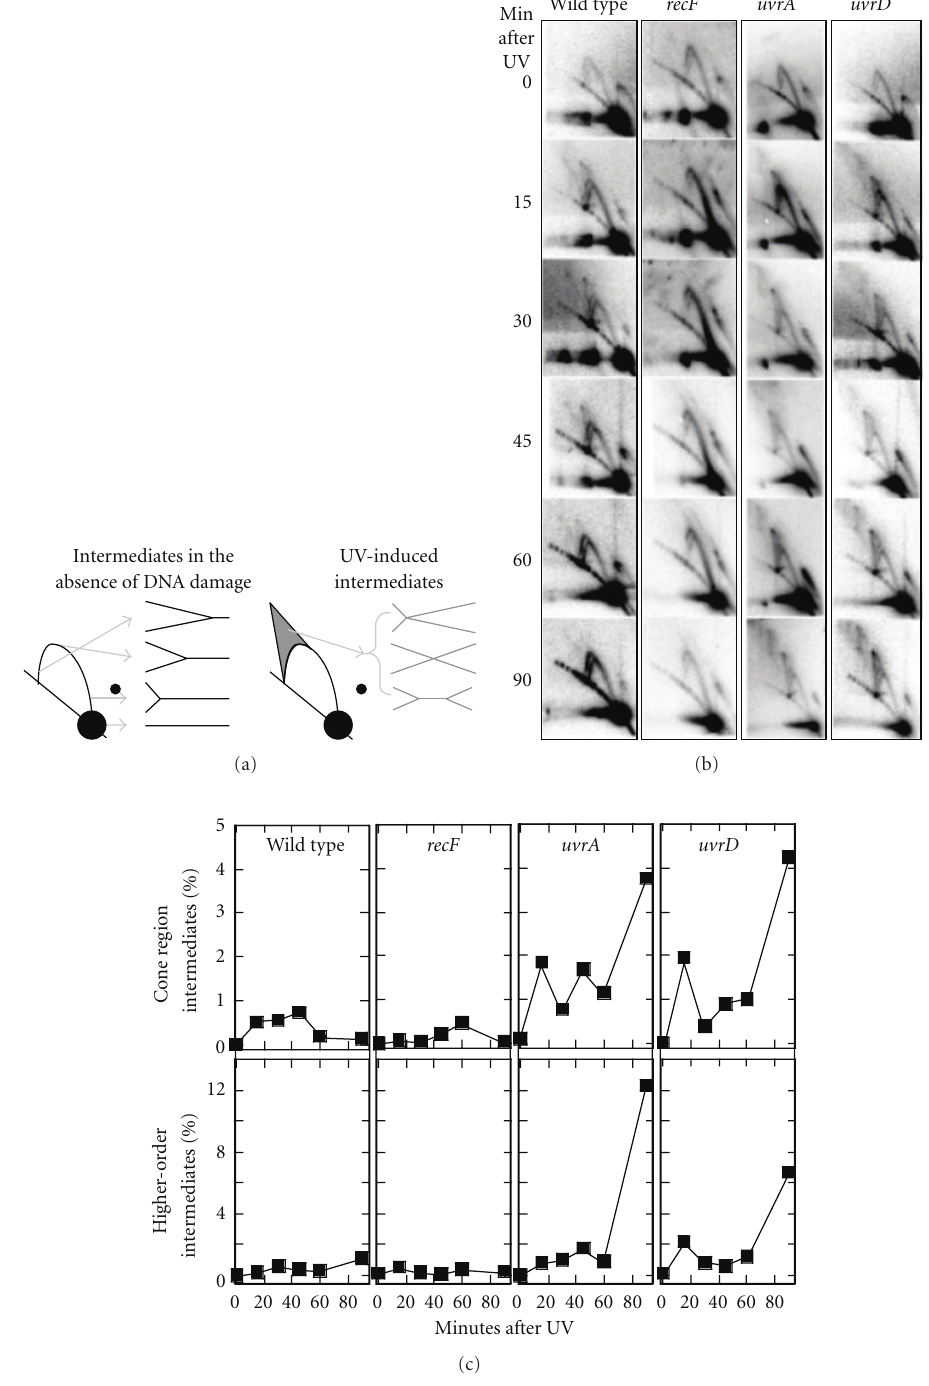
Figure 4: In the absence of UvrD, blocked replication forks persist leading to the accumulation of higher-order recombination intermediates in a manner similar to uvrA mutants. (a) Diagram of structural intermediates observed in the presence or absence of UV-induced damage. (b) Cells containing the pBR322 plasmid were UV-irradiated with 50 J/m 2 . At the times indicated, genomic DNA was purified, digested with PvuII, and the structural intermediates were examined by two-dimensional agarose gel analysis. Gels shown are representative of at least two independent experiments. (c) The percentage of UV-induced intermediates relative to nonreplicating plasmids over time is plotted. Percentages were quantified as the ratio of radioactivity in either the cone region or the high-order intermediate region over the amount of radioactivity in the nonreplicating